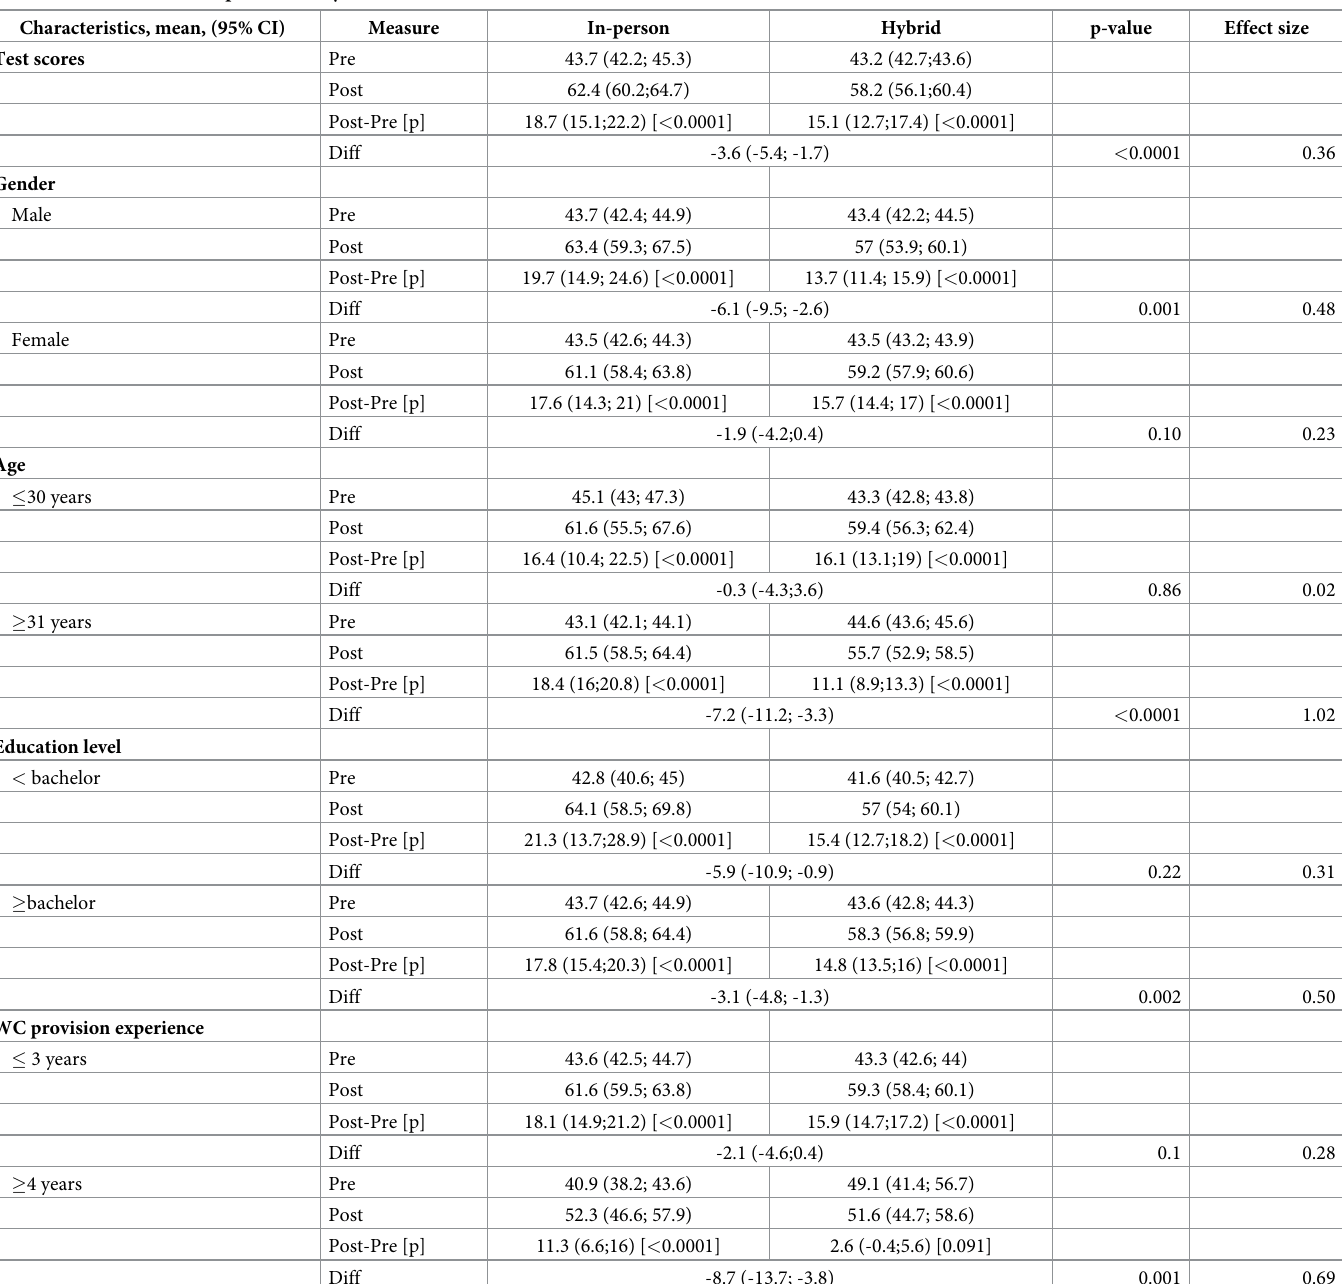
Table 6. Effectiveness of In-person and hybrid interventions. Characteristics, mean, (95%